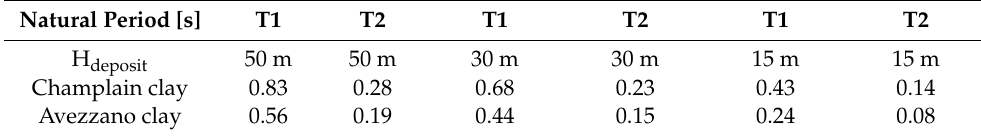
Table 2. Natural vibration periods T1 and T2 for the investigated case